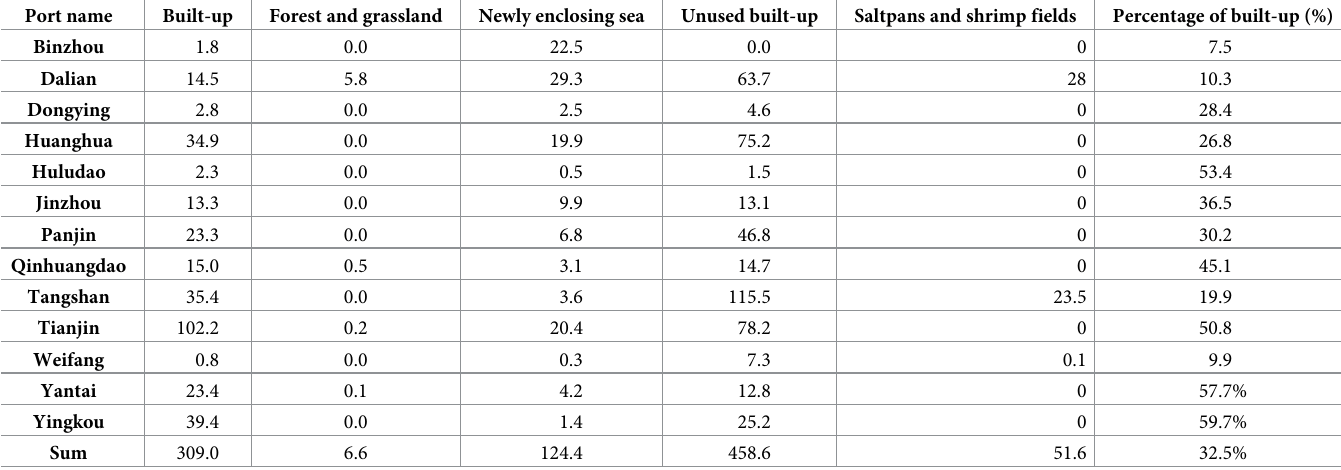
Table 4. Areas of different land use types within the port boundary in the Bohai Sea in 2018 (Unit: Km 2 ). Port name